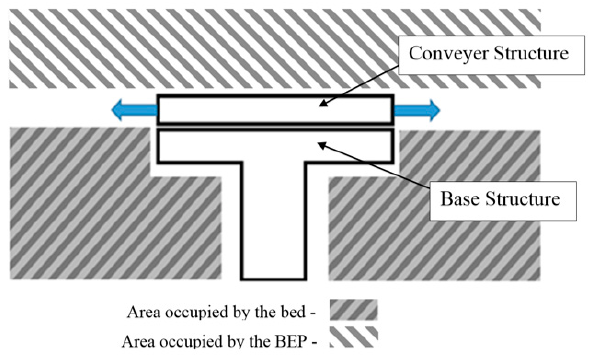
Figure 1. Obstructed areas.